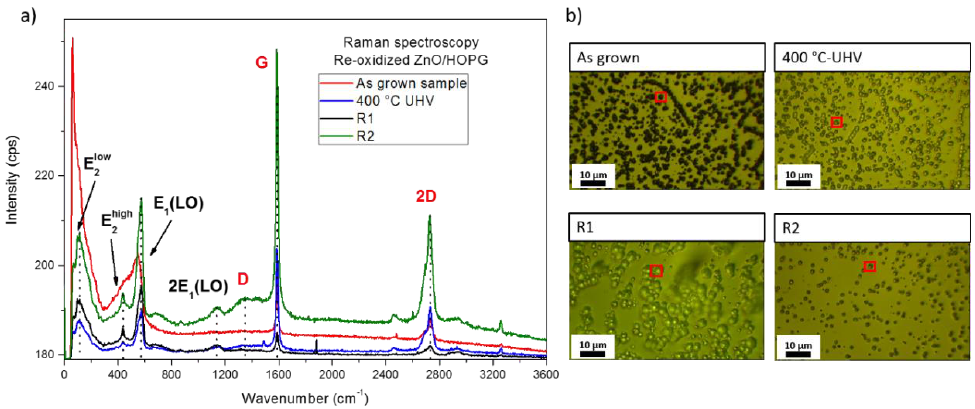
Figure 6. ( a ) Average Raman spectra for each thermal treatment. Main ZnO bands (black labels) and graphite bands (red labels) are indicated; ( b ) optical images of ZnO clusters on HOPG after different thermal treatments. Red squares indicate the mapped area.